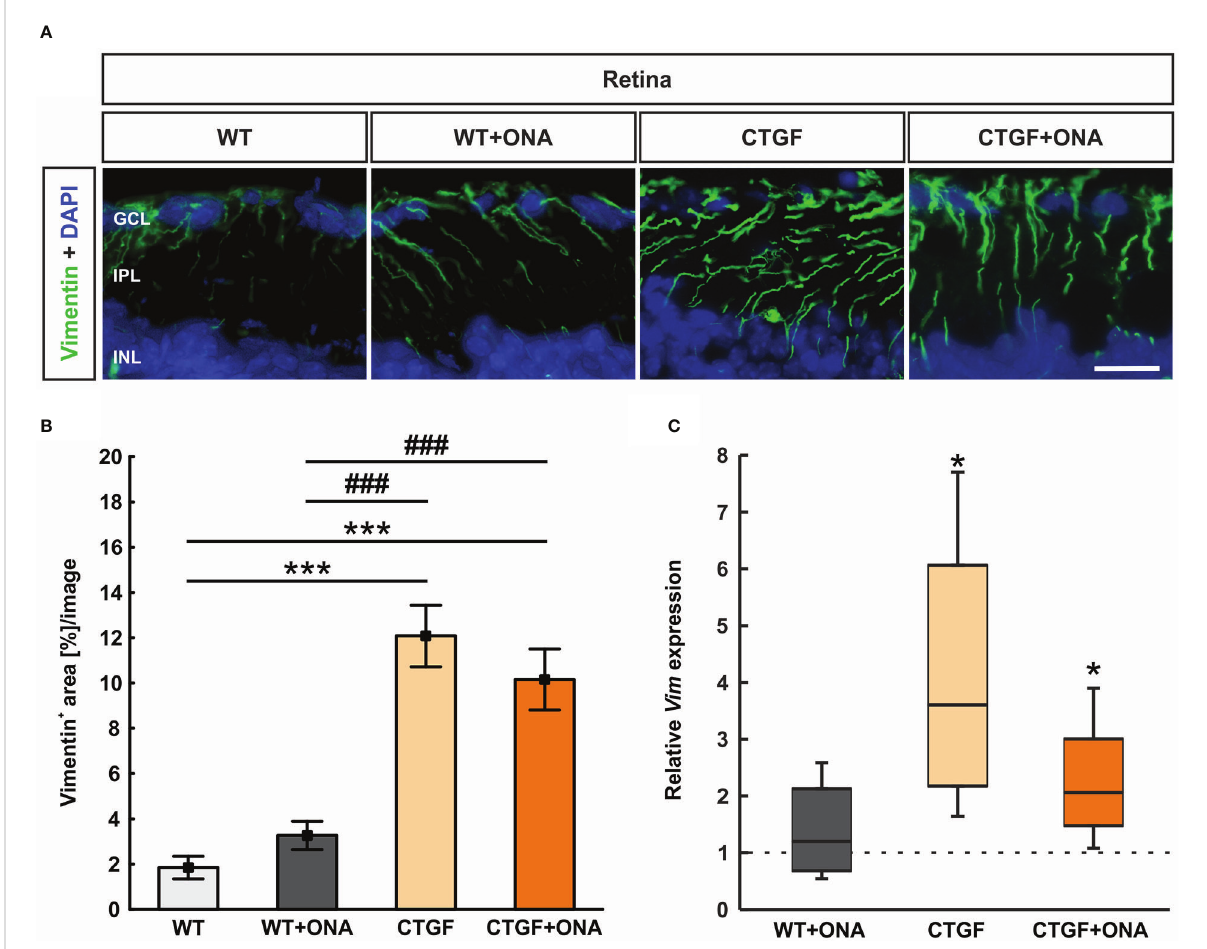
FIGURE 8 Stronger macrogliosis in CTGF and CTGF+ONA retinae. (A) Cross-sections were labelled with an antibody against anti-vimentin (green) to mark astrocytes and DAPI stained cell nuclei (blue). (B) The vimentin + area was signi fi cantly increased in CTGF and CTGF+ONA retinae compared to WT as well as WT+ONA mice. (C) The mRNA expression levels of Vim was not changed in WT+ONA retinae, but a signi fi cant upregulation was noted in CTGF and CTGF+ONA retinae. GCL=ganglion cell layer; IPL=inner plexiform layer; INL=inner nuclear layer. Values are mean ± SEM for immunohistology and median ± quartile ± minimum/maximum for RT-qPCR. The dotted line in (C) represents the relative expression of the WT group. *p<0.05 and ***p<0.001 vs . WT; ### p<0.001 vs . WT+ONA. Scale bar: 20